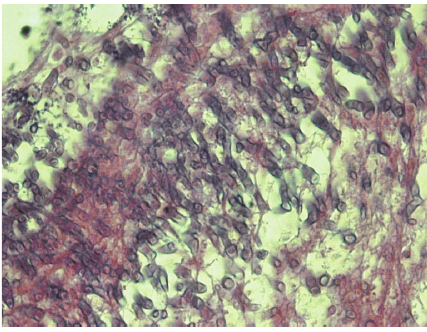
Figure 5: Fungal colonies on the surface of the necrotic mass with broad nonseptated hyphae that branch (HE × 630).